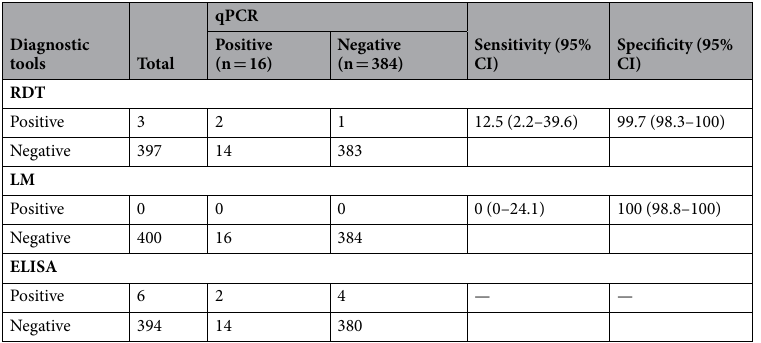
Table 4. Congenital malaria detection in cord blood samples according to LM, RDT and ELISA compared to qPCR. qPCR, quantitative real-time Polymerase Chain Reaction; LM, Light Microscopy; RDT, Rapid Diagnostic Test; ELISA, Enzyme-Linked ImmunoSorbent Assay; CI, Confidence